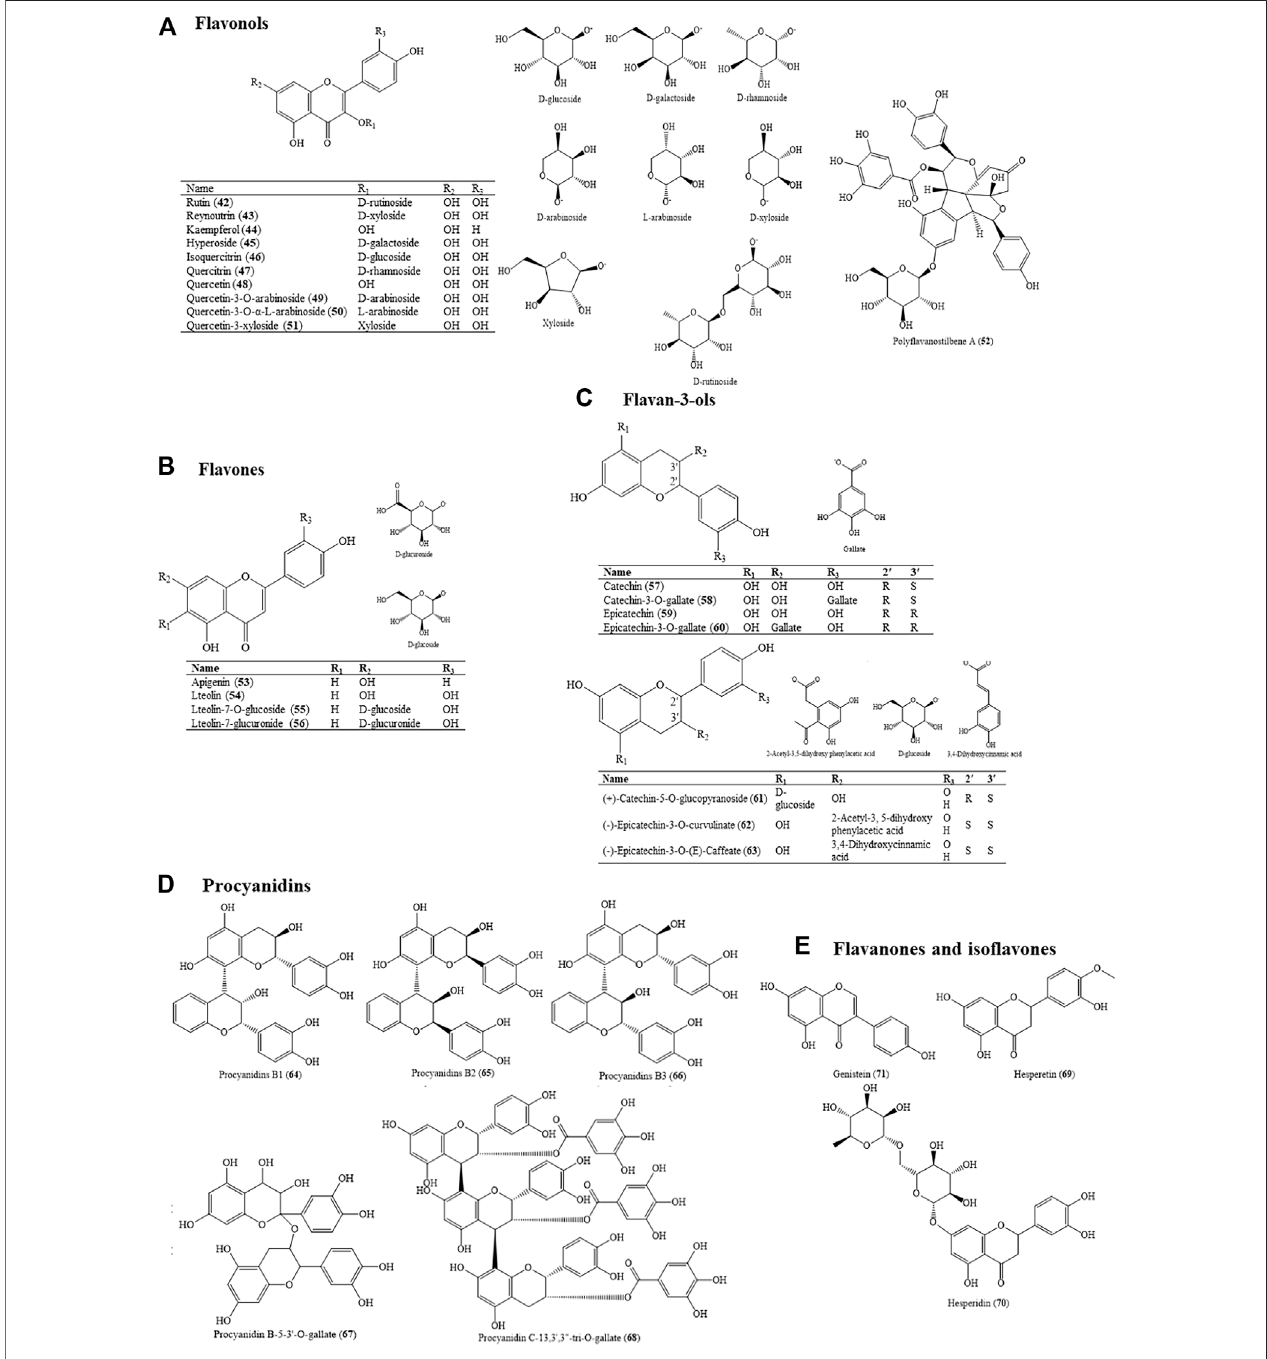
FIGURE 5 | Molecular structure of fl avonoids (A) . Flavonols, (B) . Flavones, (C) . Flavan-3-ols, (D) . Procyanidins, and (E) . Flavanones and iso fl avones in HZ.